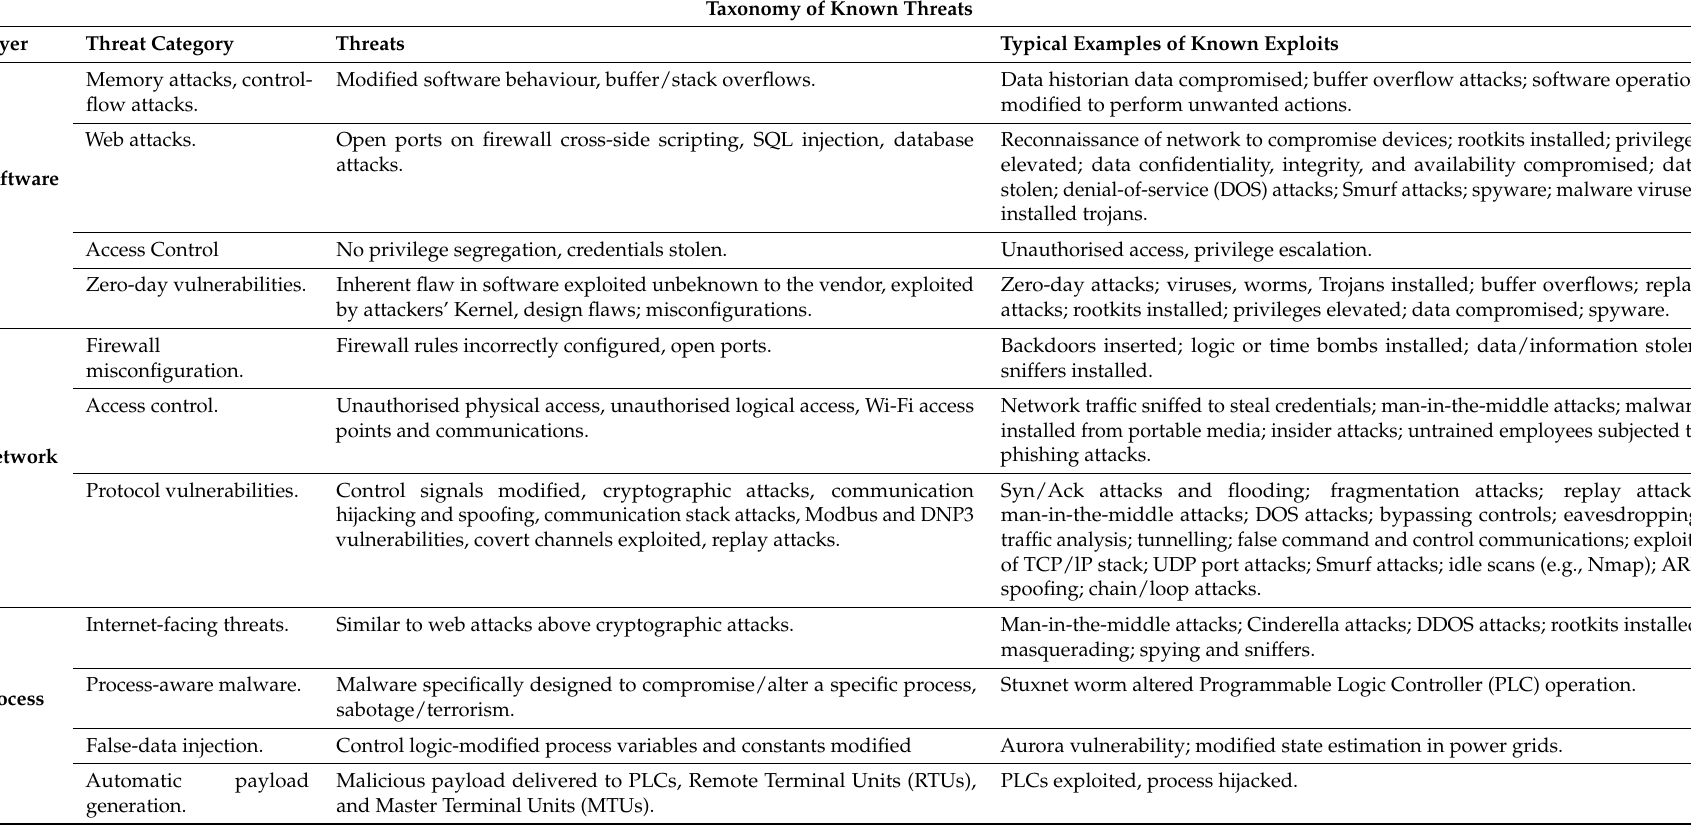
Table 1. Taxonomy of known